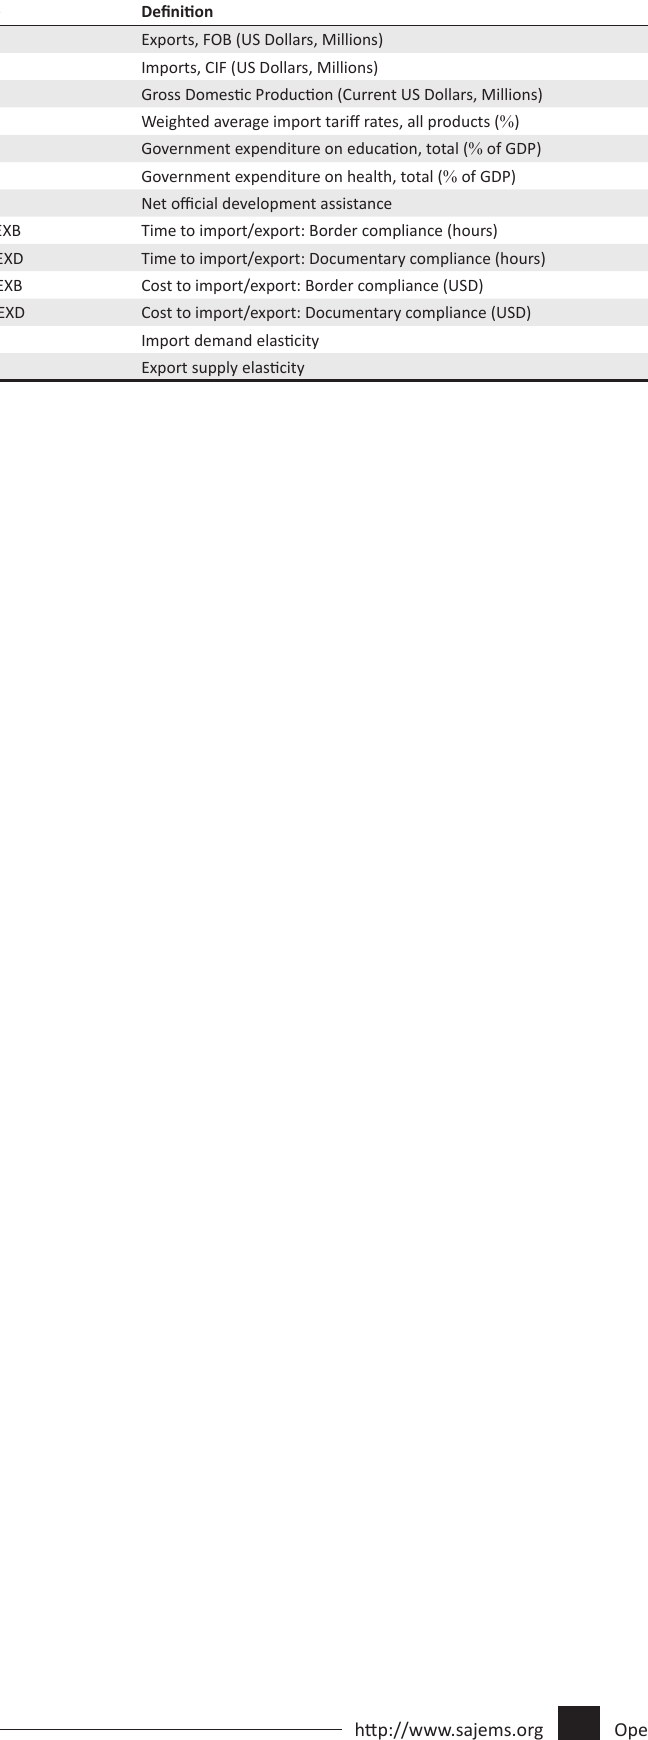
TABLE 1-A1: List of variables and data sources used in analysis.